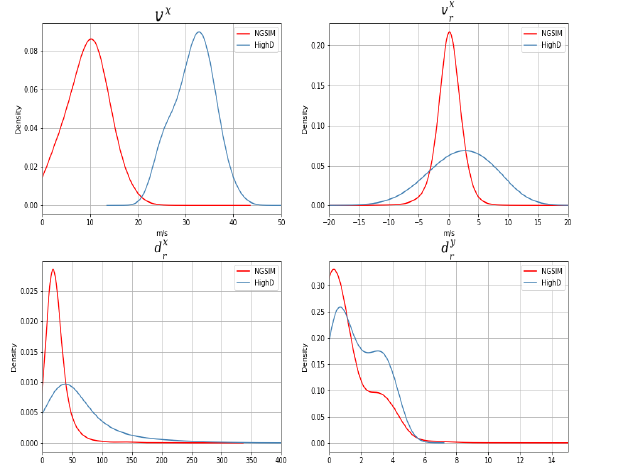
Figure 8. An illustration of cut-in case.